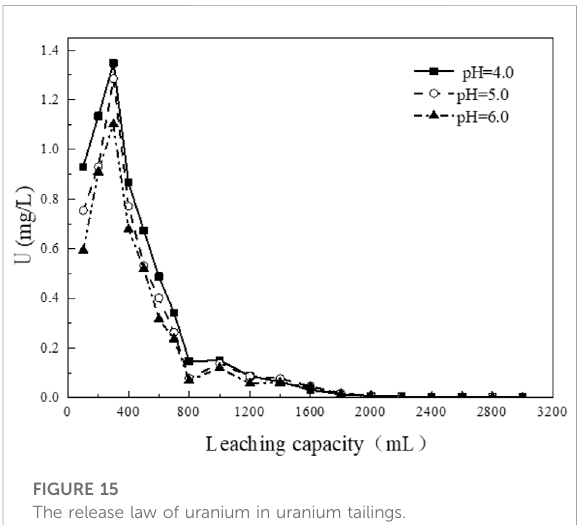
FIGURE 15 The release law of uranium in uranium tailings.